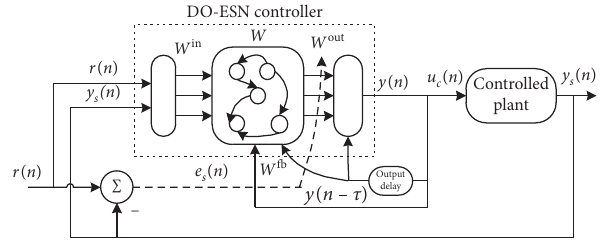
Figure 2: The controller design based on